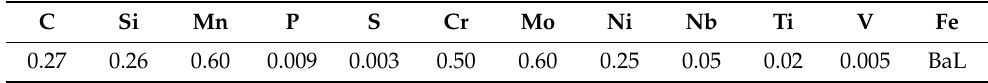
Table 1. Chemical composition of P110SS steel (wt.%).